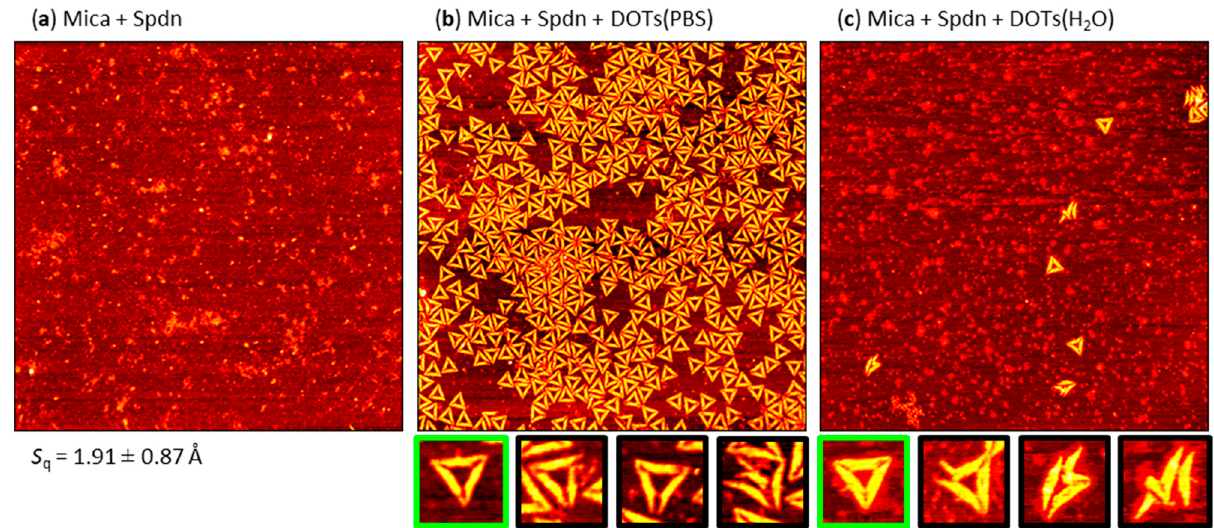
Figure 6. Representative AFM images of ( a ) a mica surface after incubation with Spdn and DOTs adsorbed from ( b ) PBS and ( c ) H 2 O at the Spdn-modified mica surface. The AFM images have a size of 3 x 3 µm² and a height scale of ( a ) 1.5 and ( b , c ) 2.5 nm, respectively. The RMS roughness S q of the Spdn-modified mica surface (average of three AFM images ± standard deviation) is given below the AFM image in ( a ). Below ( b ) and ( c ), example magnifications of intact (green) and damaged (black) DOTs are shown.